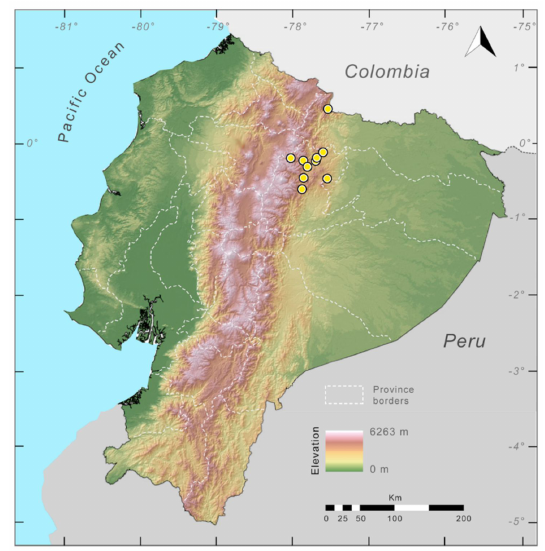
Figure 183. Distribution of Nymphargus siren in Ecuador (yellow